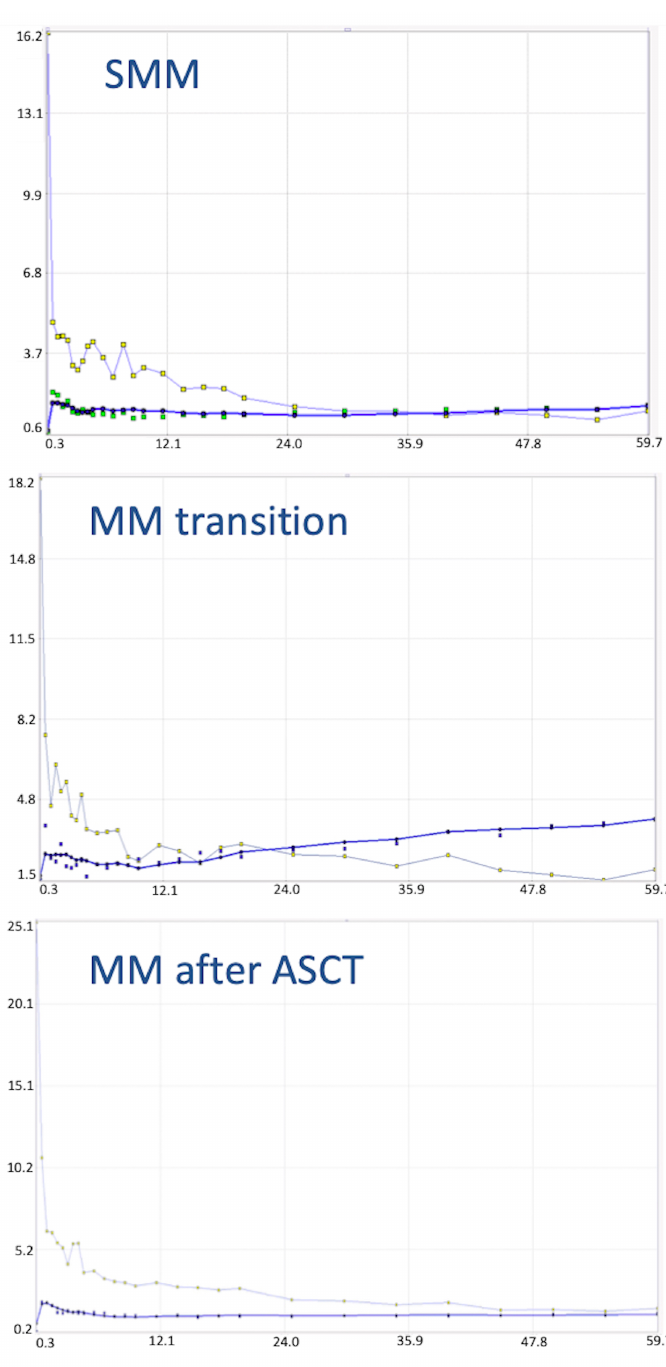
Figure 3. Time activity curves (TACs) depicting 18 F-FDG concentration during the 60 min of dynamic PET acquisition upon SMM diagnosis (upper row), at transition to symptomatic myeloma (middle row) and after therapy with tandem HDT and ASCT (lower row). The curves are derived from the bone marrow of the iliac bone (thick blue curve with green dots) and from the common iliac artery (thin blue curve with golden dots). The TAC at baseline imaging shows a relatively stable tracer concentration over time. The transition from asymptomatic SMM to symptomatic MM is accompanied by a change in the respective TAC of the radiotracer, showing a steadily increasing accumulation in the bone marrow compared to the definitely lower tracer concentration upon SMM. After the therapeutic intervention, we notice a decrease of the 18 F-FDG concentration in the bone marrow, which is also reflected in the slope of the